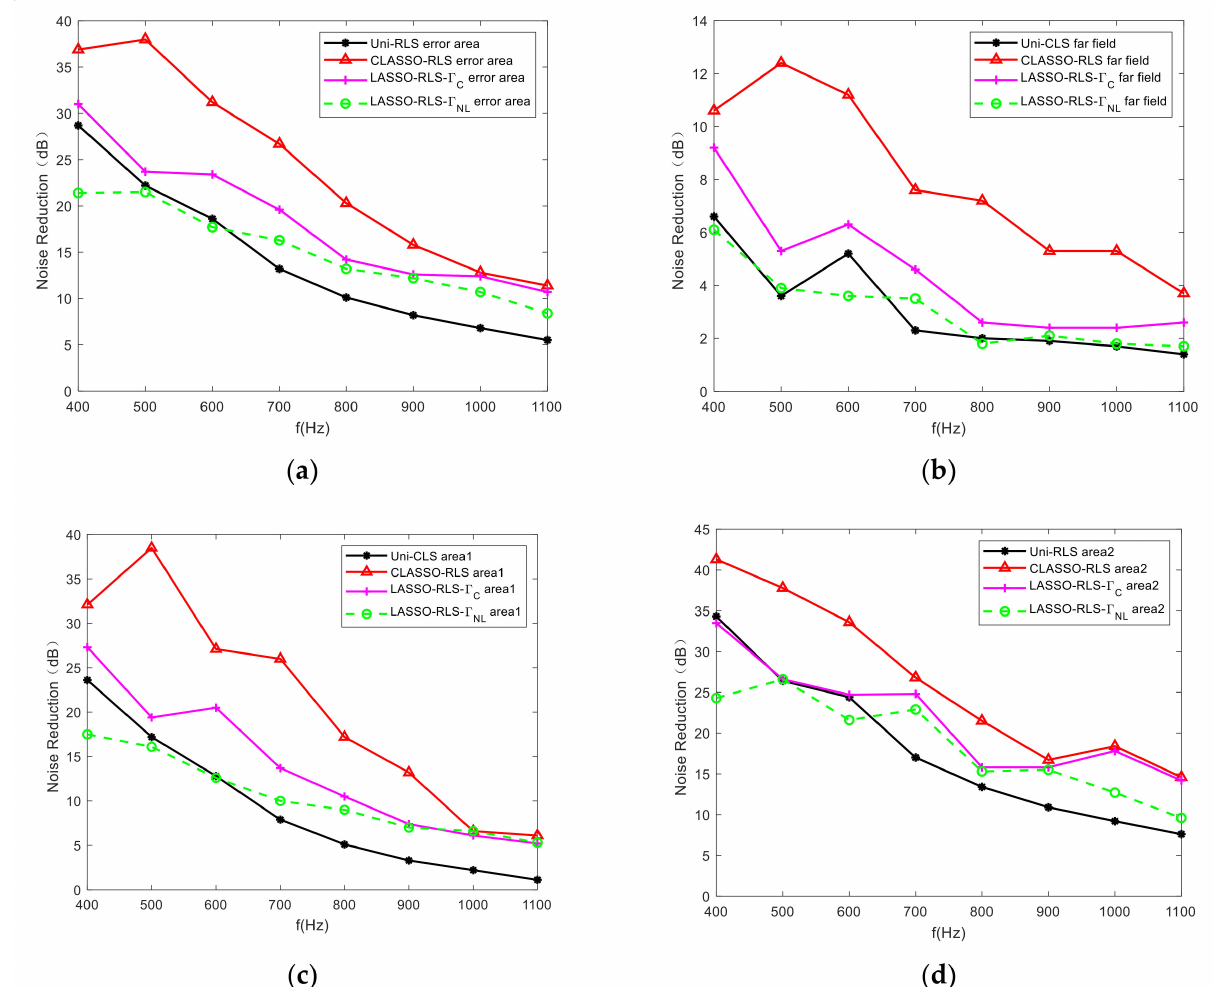
Figure 4. Comparisons of the noise reduction for each method from 400 Hz to 1100 Hz: ( a ) the comparison of the noise reduction in the target area; ( b ) the comparison of the noise reduction in the far-field observing area; ( c ) the comparison of the noise reduction in the target area 1; and ( d ) the comparison of the noise reduction in the target area